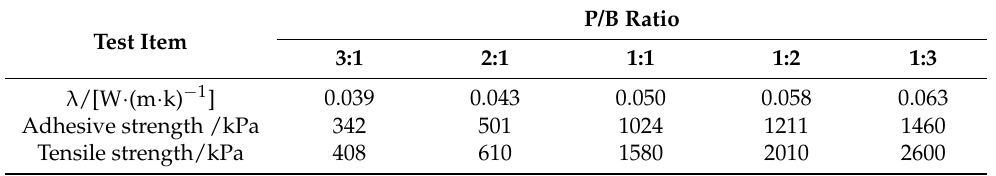
Table 4. Thermal conductivity and adhesive strength of the coating with various P/B